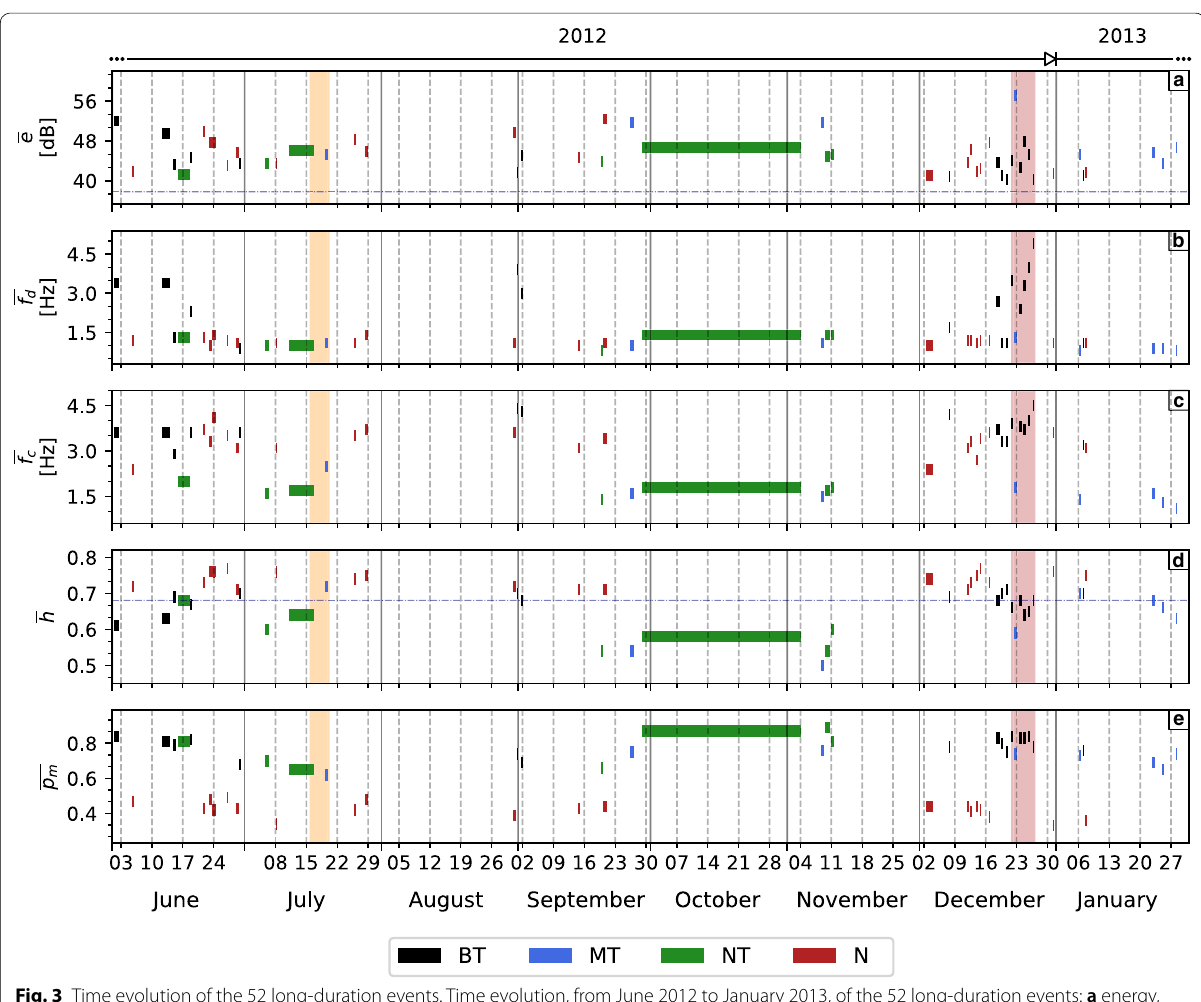
Fig. 3 Time evolution of the 52 long-duration events. Time evolution, from June 2012 to January 2013, of the 52 long-duration events: a energy, b dominant frequency, c centroid frequency, d permutation entropy, and e dominant polarization degree. The length of each bar represents the duration of the selected periods, whereas blue horizontal lines in a and b depict the average value throughout the entire period analyzed. Black vertical dashed lines show the beginning of weeks, while the black continuous vertical lines show the beginning of